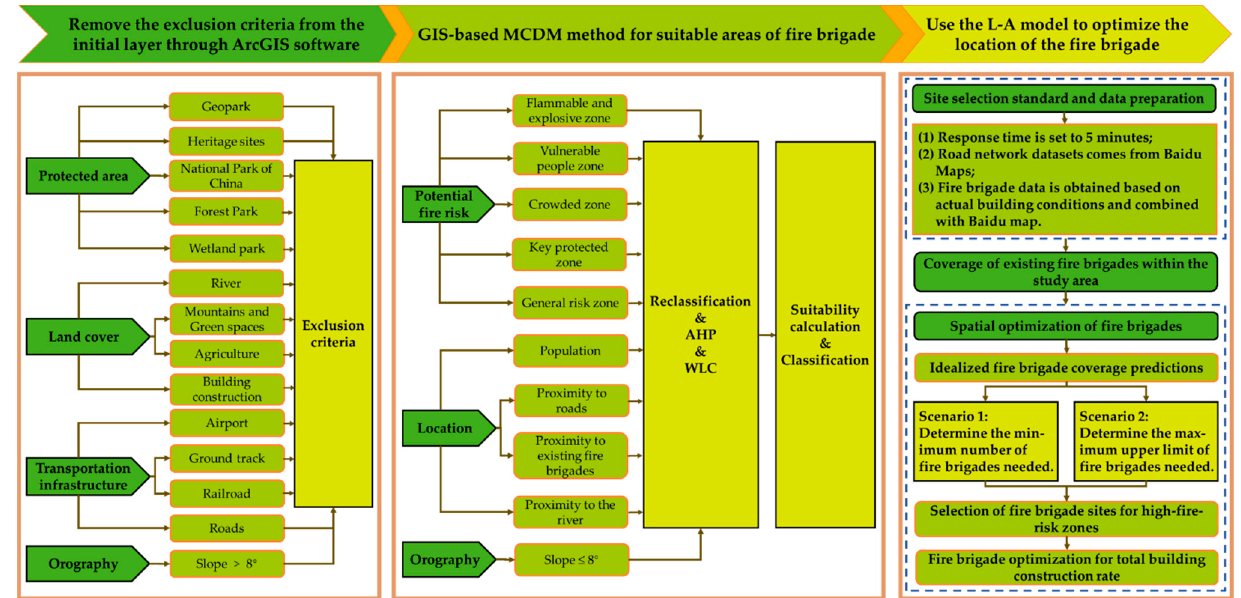
Figure 2. Flow chart of proposed method for selecting fire brigade locations.